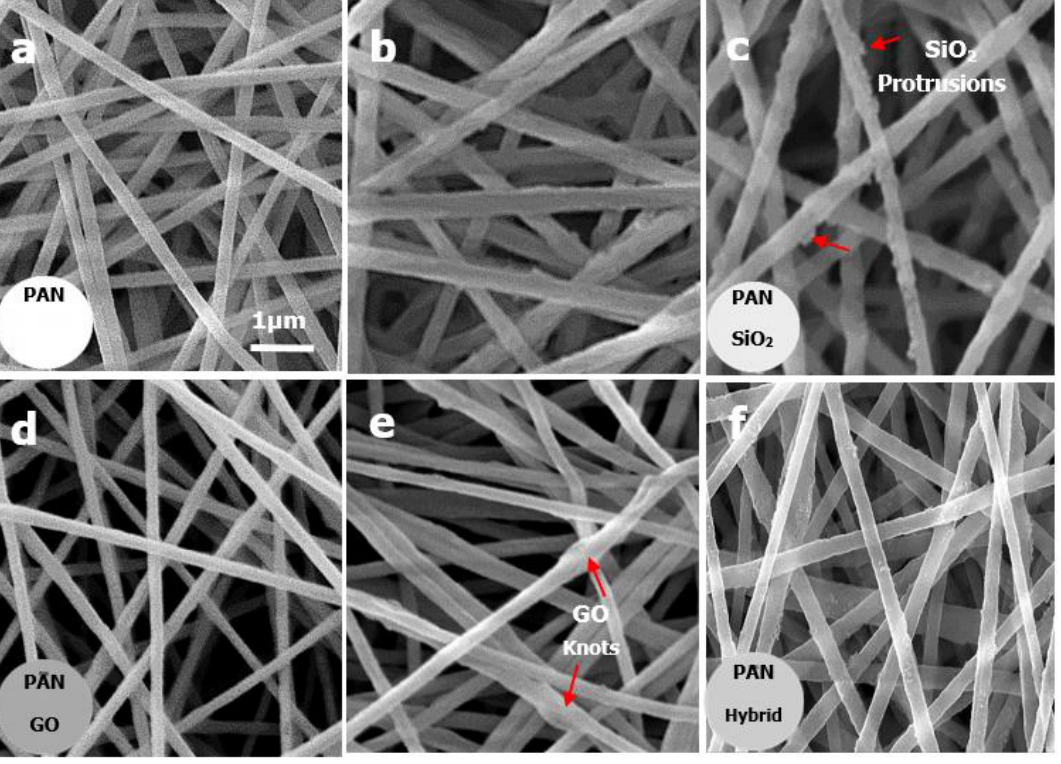
SEM images of developed membranes, ( a ) PAN, ( b ) PAN-4SiO 2 , ( c ) PAN-7.5SiO 2 , ( d ) PAN-0.5GO, ( e ) PAN-1.5GO, and ( f ) PAN-1.5GO-7.5SiO 2 . Inset shows digital images of the electrospun membranes (area = 20 cm 2 ) used for separation test.